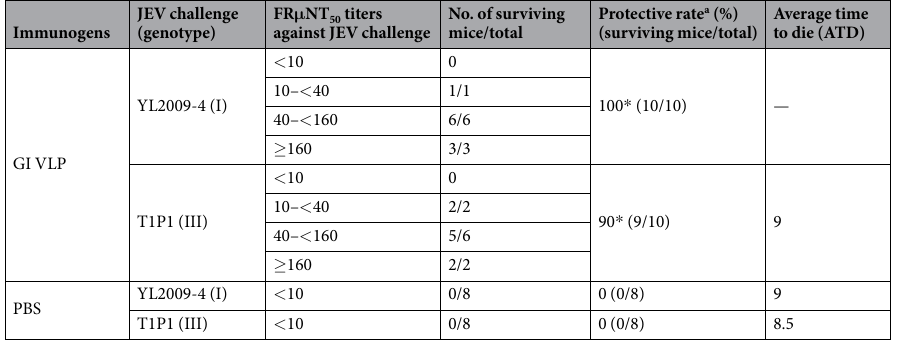
Table 1. Protection of GI JEV VLP vaccine against GI and GIII JEV infection in mice. a Data was compared by Student t test. * P <